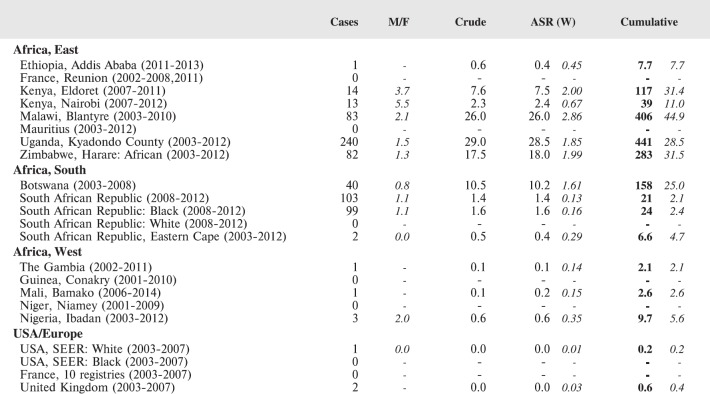
Crude, age-standardised (world) and cumulative (0–14) incidence rates (per million) and standard errors—Kaposi sarcoma.